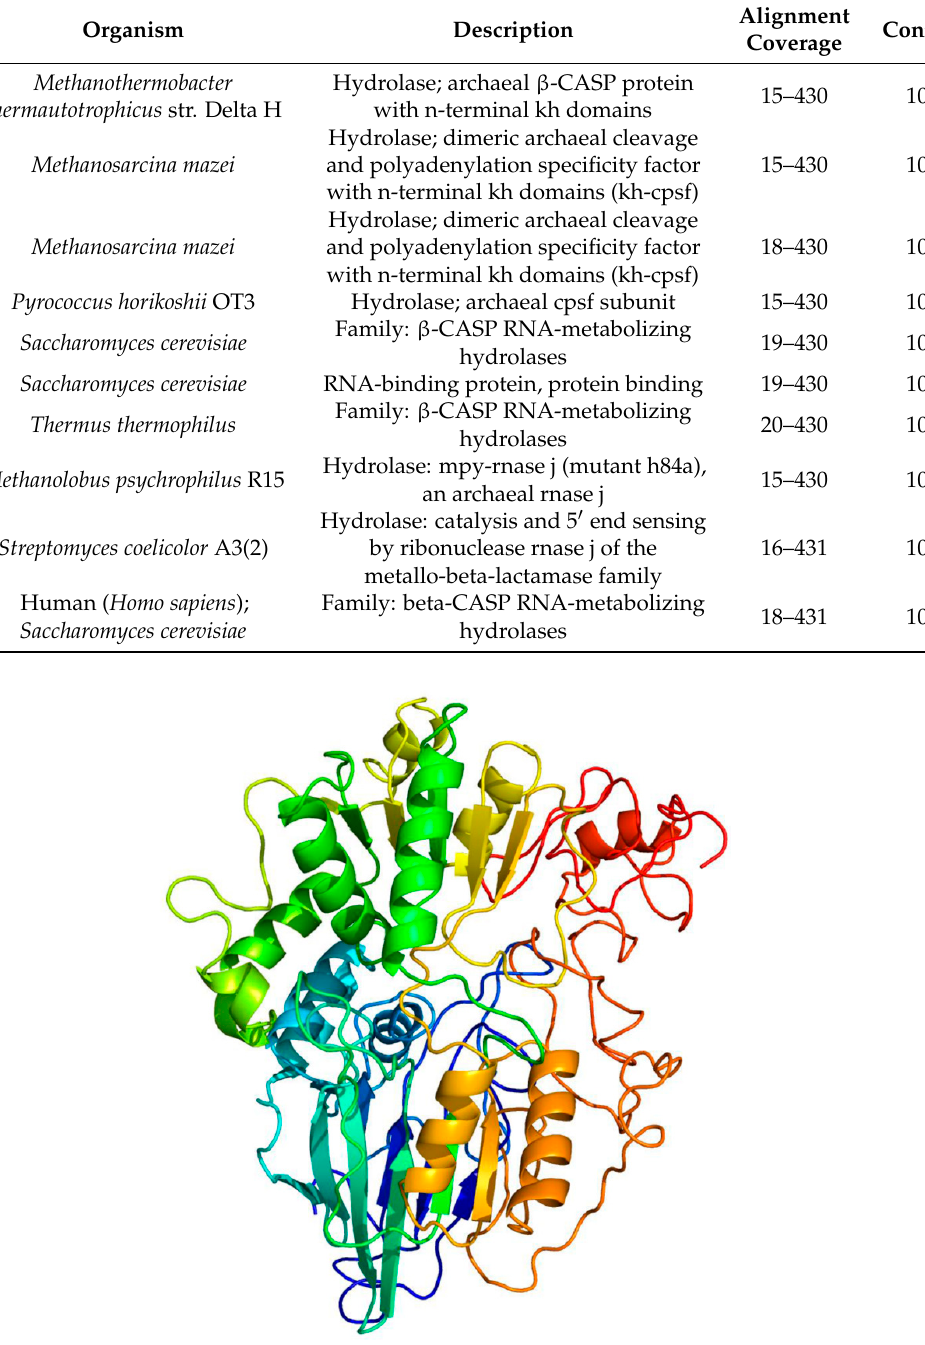
Figure 1. Phyre2 modeling of the Fremyella diplosiphon PsoR protein. The structure of Fd PsoR was modeled on the β -CASP containing enzyme MTH1203 from Methanothermobacter thermautotrophicus [46,47]; 82% of the Fd PsoR residues were modeled at >90% confidence. The protein is rainbow-colored: red (N-terminus) to blue (C-terminus). This figure was made/generated by Alicia Layer.